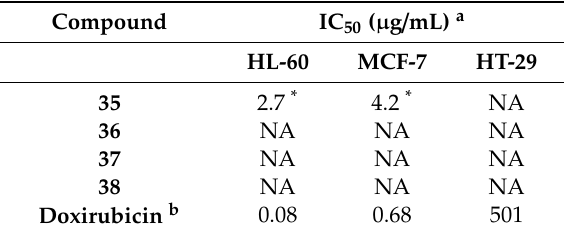
Table 3. Cytotoxic properties for compounds 35 – 38 isolated from Premna odorata